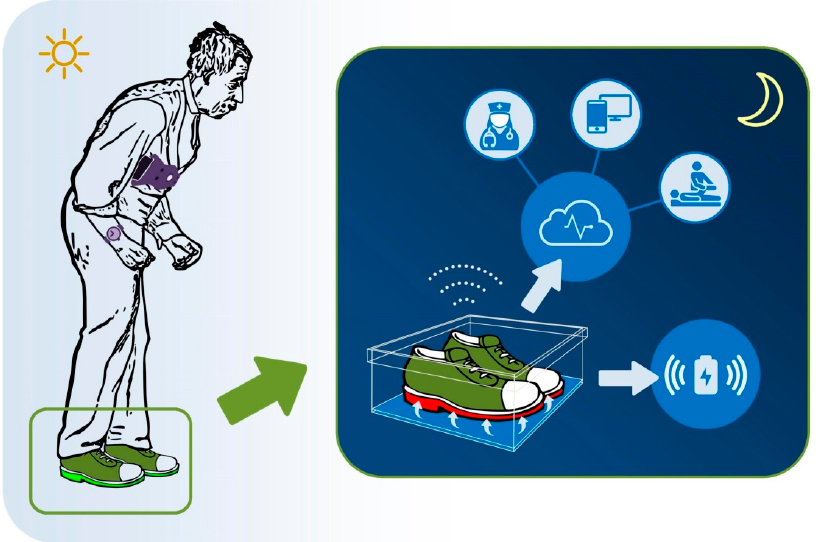
Figure 3. Practical use of smart shoes within the IoHT: capturing gait signals of patients with impaired gait (daytime use), data storage, and battery charging (nighttime use). Icons modified and printed with permission of [3–5]. Patient figure adapted from [6].